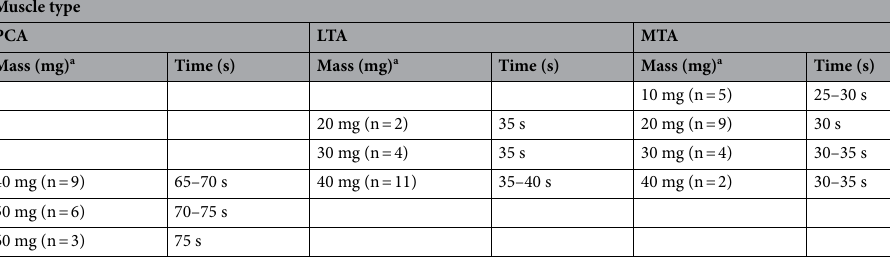
Table 3. Recommended range of optimal disruption times using adult rat ILMs. The appropriate span of rotor–stator disruption attributed to the rodent stage, the total weight of the specimen, and muscle type are shown. The listed ranges were collated based on extraction efficiency. a Total muscle weights using 3 pooled tissues.